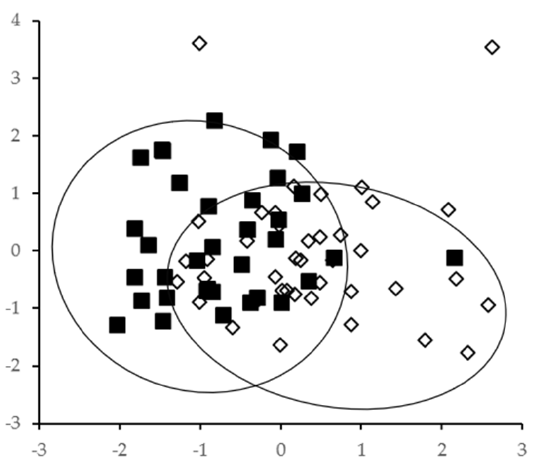
Figure 2. Two-dimensional plot representing the scores for PC1 (x axis) and PC2 (y axis) obtained for plasma samples of the observational study ( n = 151): samples of quartile 0 (low dairy intake, (cid:4) ); samples of quartile 3 (high dairy intake, ♦ ). The principal component analysis (PCA) was carried out including plasma concentrations of all individual FAs and the intake of dairy fat, olive oil, red meat, fish, and cakes and biscuits. PC1 explained 32.2% of the total variance, and PC2 explained